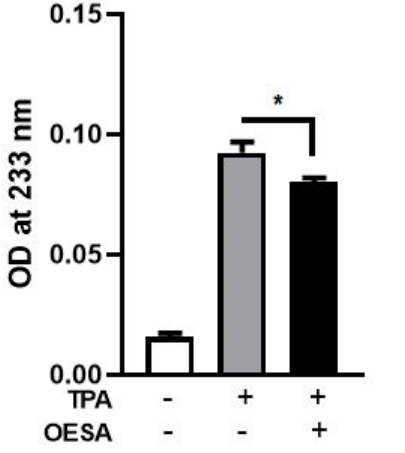
Figure 5. Conjugated diene levels determination on Raji cells treated with OESA after 48 h induction of viral cycle. Raji cells were exposed, or not, to TPA (8 nm) and OESA (0.31 mg/mL) simultaneously at a noncytotoxic concentration of 0.3 mg/mL. The levels of DC produced were evaluated by measuring the OD at 233 nm (*: p < 0.05). Results were expressed as mean ± standard deviations (n = 3).